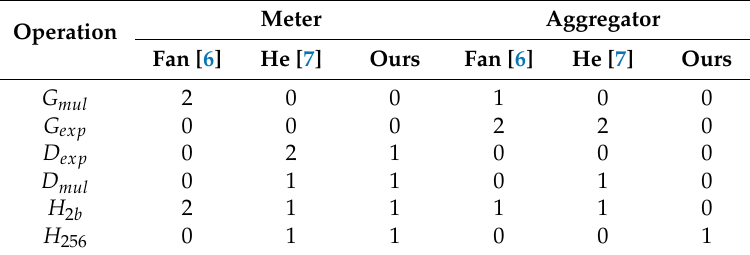
Table 9. Computation cost of the registration phase.